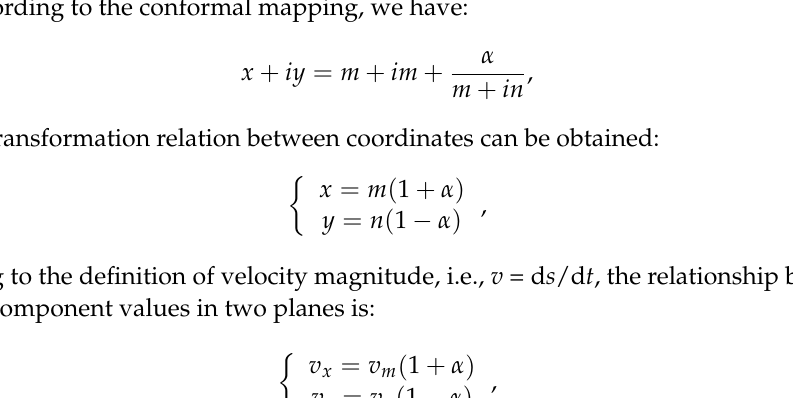
Figure 2. Schematic of the process of the conformal mapping from z -plane to ζ -plane. According to the conformal mapping, we